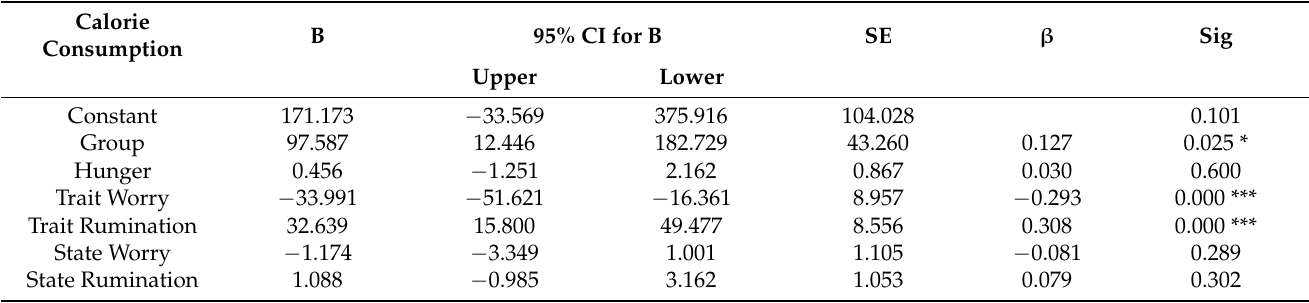
Table 2. Summary of results from the predictors for the multiple regression analysis for total